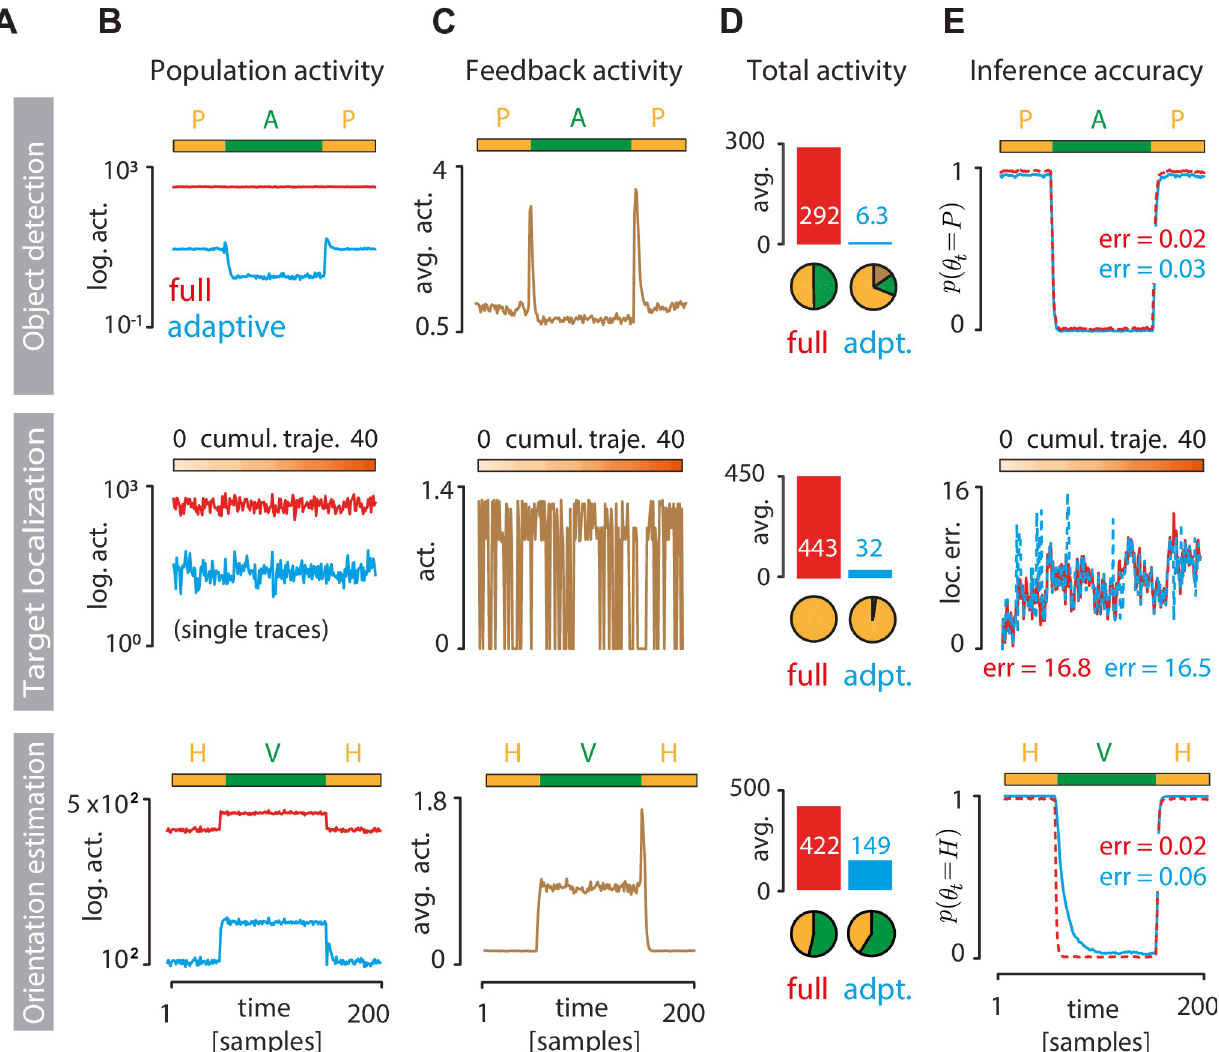
Fig 4. Adaptive coding significantly reduces activity cost with minimal impact on inference accuracy. (A) Rows correspond to inference tasks: object detection (top), target localization (middle), and orientation estimation (bottom). (B) Sensory population activity h | z optimized for image reconstruction (red = full code) or for a particular task (blue = adaptive code). Activities in object detection (top) and orientation estimation (bottom) tasks were averaged over 500 switches between different states of the environment. For the target localization task (middle), we plot a short nonaveraged activity segment (200 time steps out of a 10 4 time step simulation; see Methods). (C) Same as B but for feedback activity required to adapt the nonlinearities in the sensory population (see Methods). (D) Time-averaged activity of the full code (red bars) and adaptive code (blue bars). Pie charts show the total activity decomposed into contributions from two different environmental states (green and orange; top and bottom row only) and feedback (brown; adaptive codes only). (E) Inference accuracy (red = full code; blue = adaptive code). Estimates of the environmental state (“object present” in object detection task, top; “orientation horizontal” in orientation estimation task, bottom) were averaged over 100 environmental switches. For the target localization task (middle), inference accuracy is measured as mean squared error between the true and inferred position of the target cross. Text insets display the average inference error in each task (see